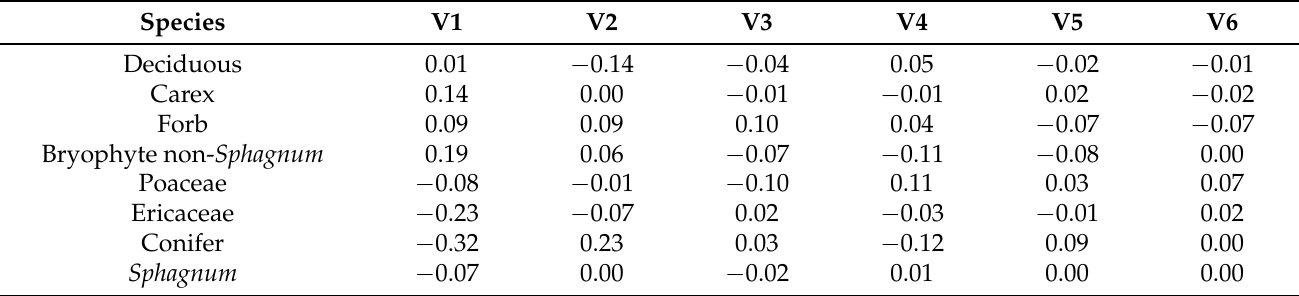
Table A3. Species scores from Isomap for the first six dimensions (Vectors “V” from 1 to 6, of the handheld dataset